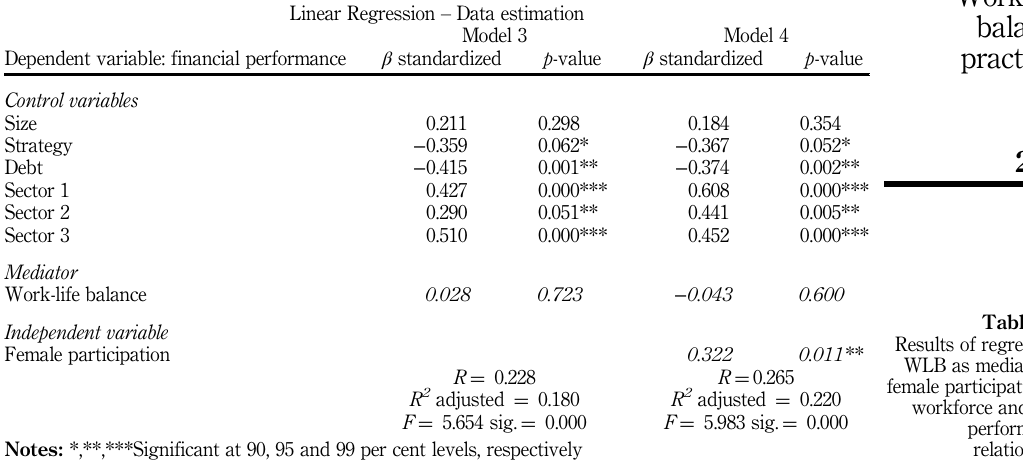
Table VI. Results of regression: